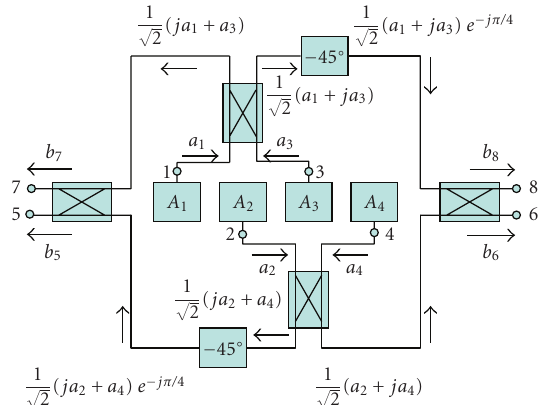
Figure 4: The simplified block diagram of a multiport antenna